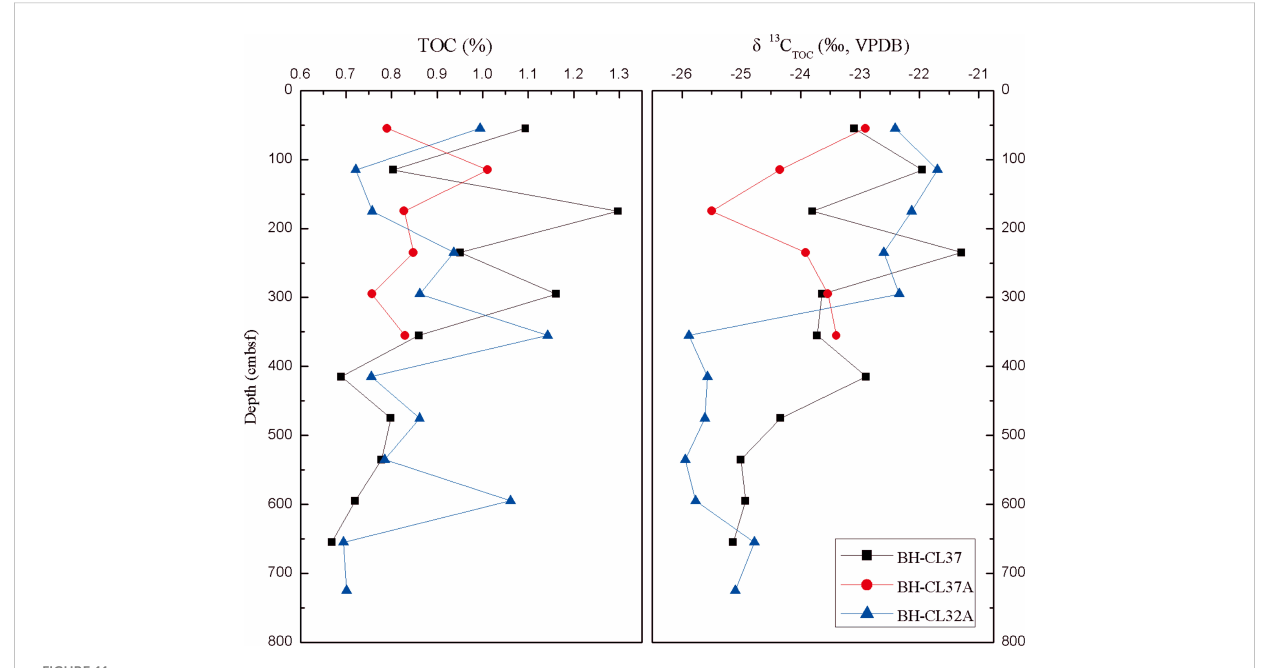
FIGURE 11 Depth pro fi les of TOC and d 13 C TOC in the